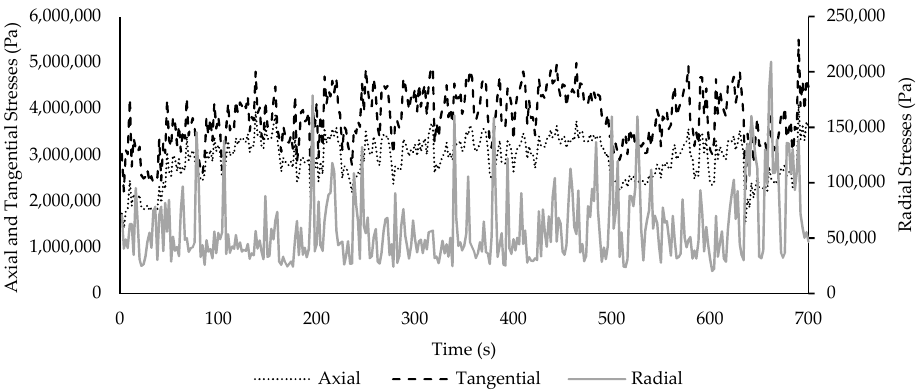
Figure 15. Pressure distribution (Pa) on the grout surface obtained from the static analysis.